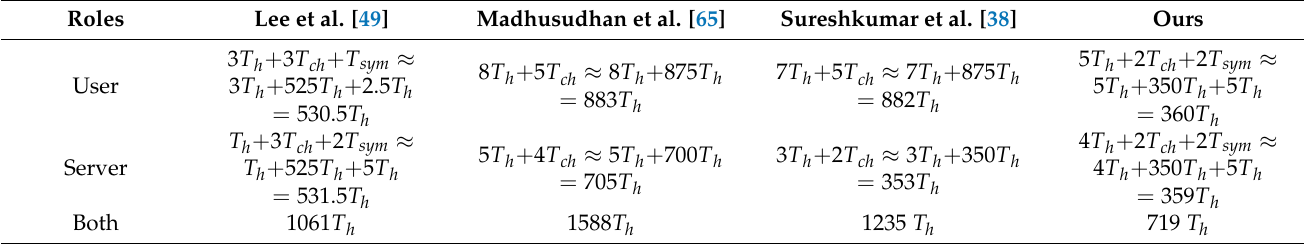
Table 4. Comparisons of Computational Complexity.